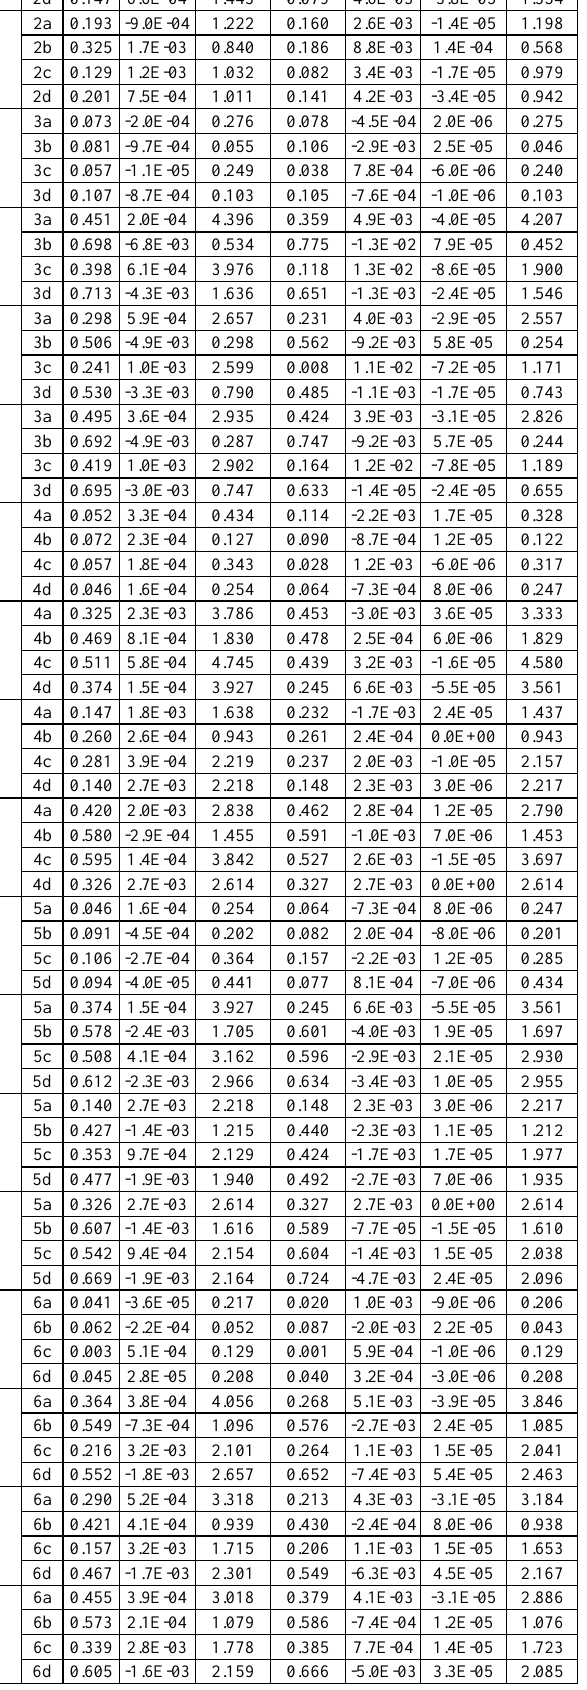
Table 3. Parameters of polynomials and the residuals of the sample crowns spectral reflectance factor of the pixels along